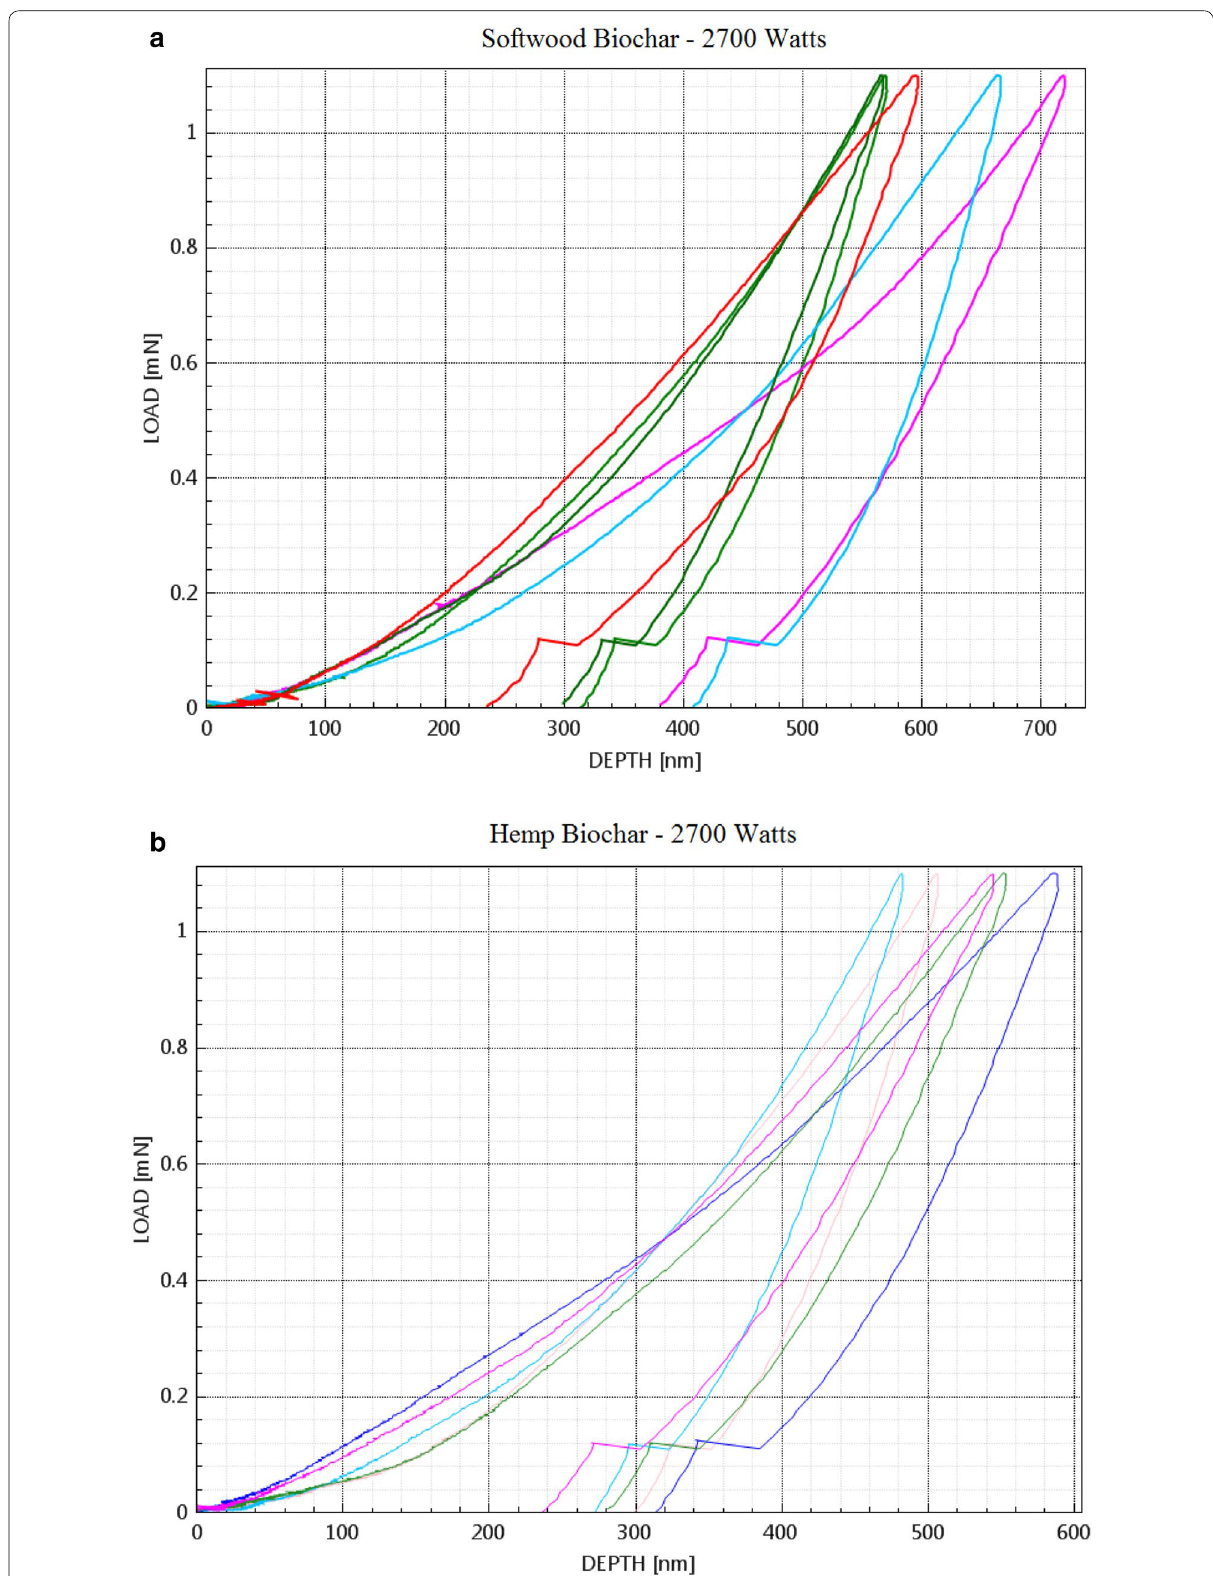
Fig. 8 Elastic behavior of biochar particles for a softwood and b hemp at 2700